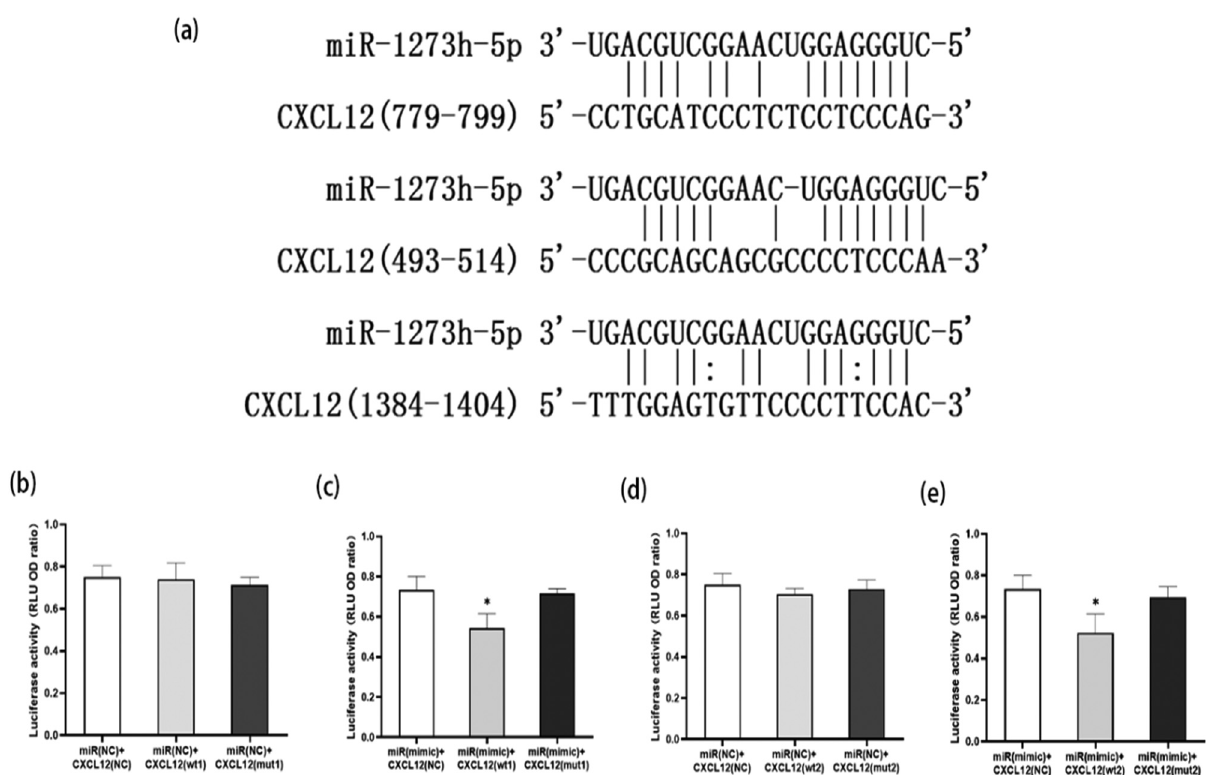
Figure 6: Bioinformatics analysis of miR - 1273h - 5p and target gene correlation. ( a ) Potential targeting ( binding ) site of miR - 1273h - 5p on CXCL12 mRNA predicted using TargetScan and miRanda software. ( b and d ) After the combination of miR - 1273h - 5p - negative control plasmid with CXCL12 plasmids, including negative control, wide type, and mutation. ( c and e ) In comparison with negative control group, the RLU ratio of miR - 1273h - 5p mimic combined with CXCL12 wide - type plasmid signi fi cantly decreased. All transfection trials were conducted using the HKE293 cells ( * P < 0.05 )